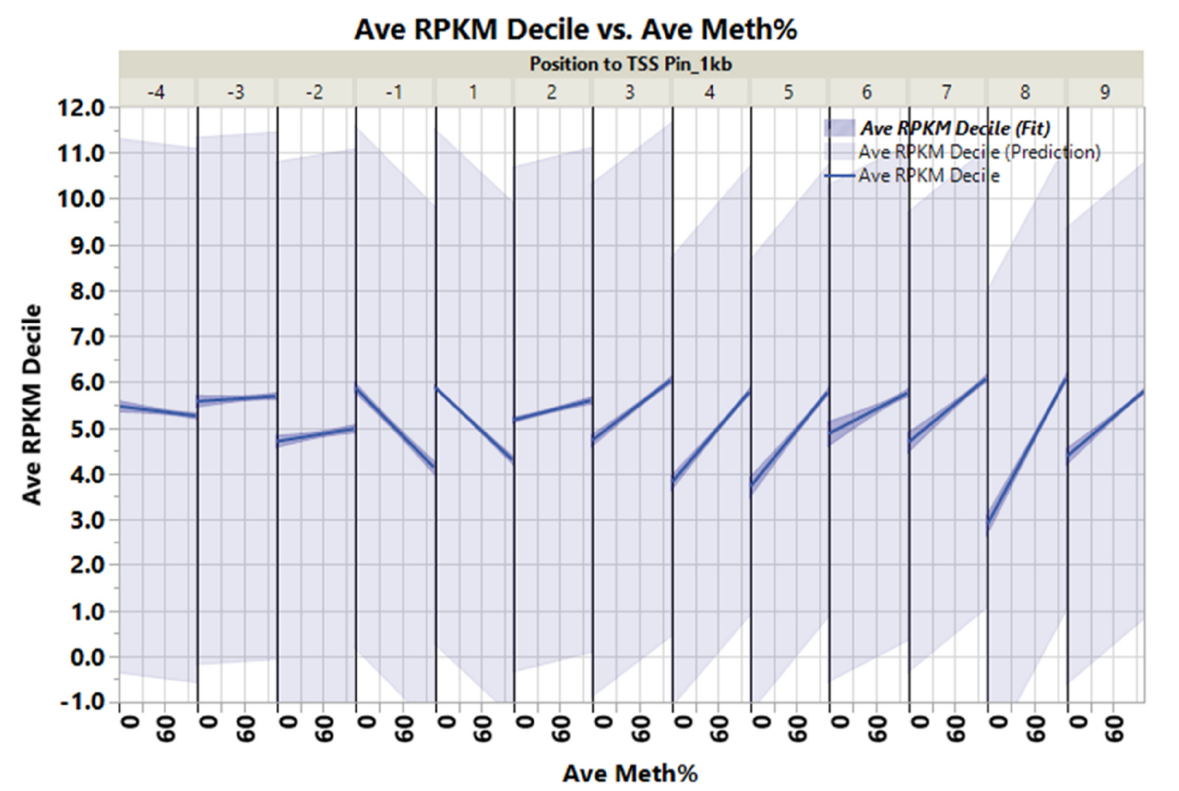
Figure 6. Inverse relationship between gene expression decile and DNA methylation in ±1 kb flanking TSS and positive correlation in +2 to +9 kb of the gene body.